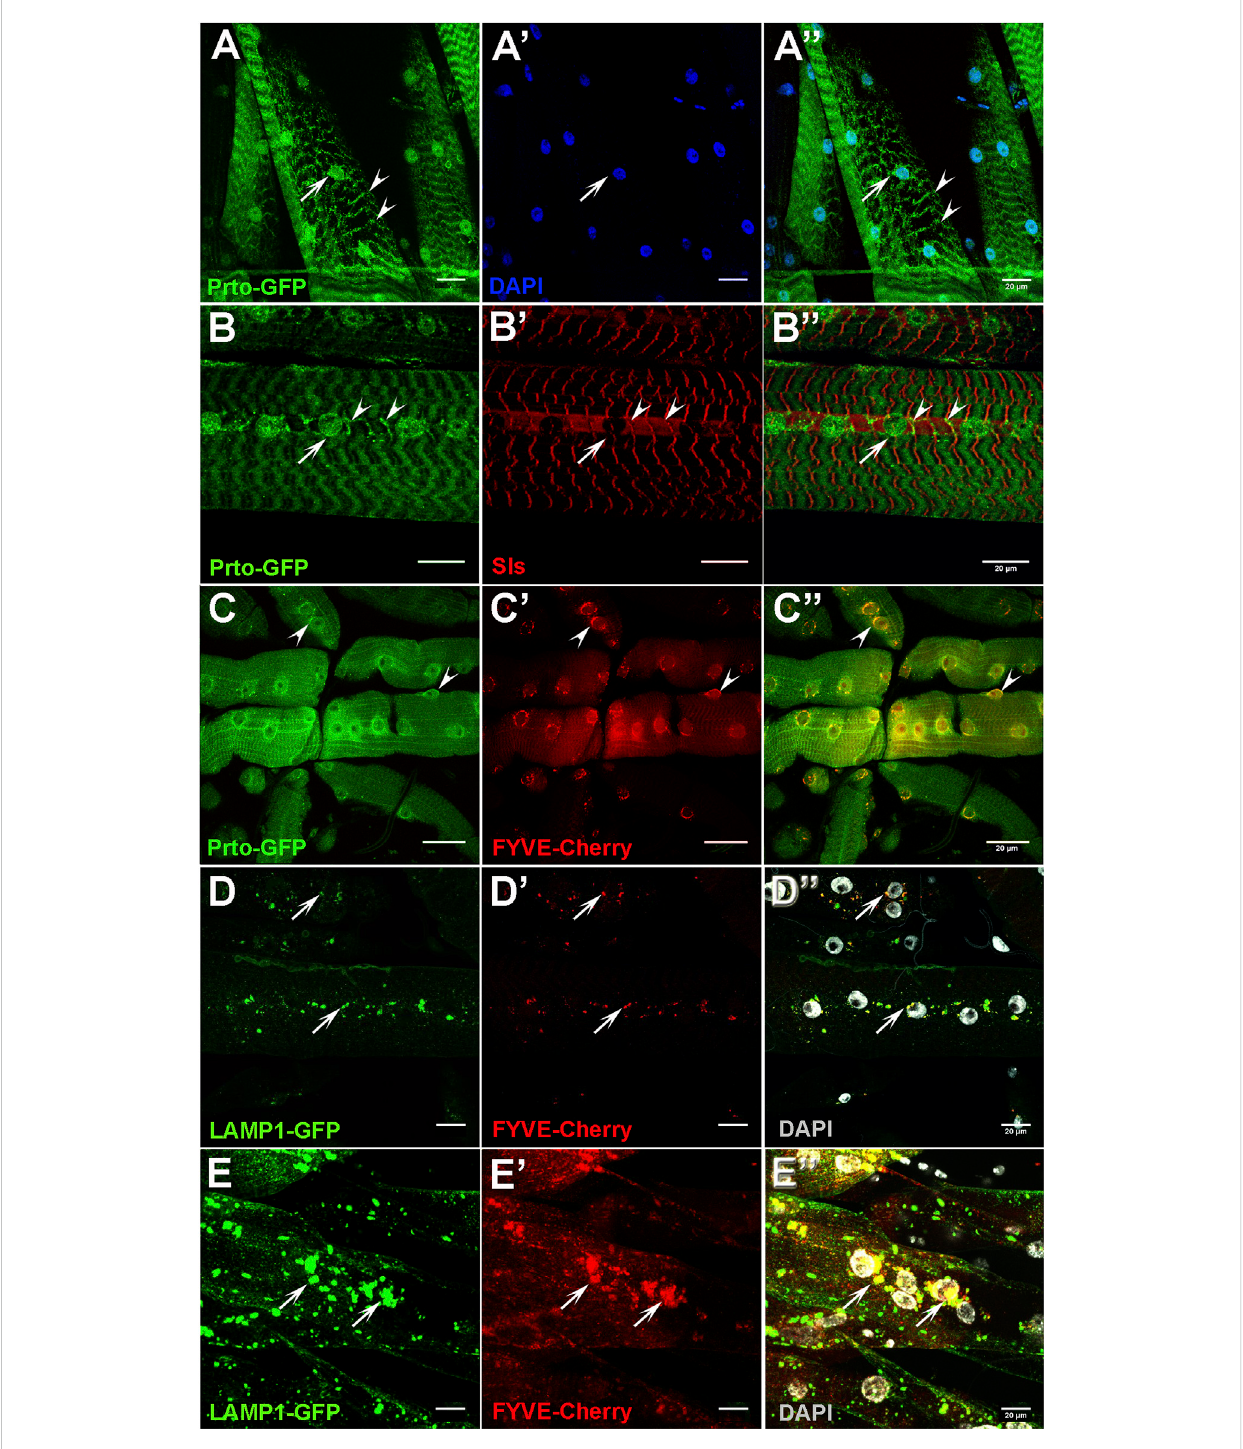
FIGURE 4 Prtolocalisationinendo-lysosomesandZ-diskcompartmentsareimportantformusclefunction. (A – A 9 ) ExpressionofGFP-taggedPrtopeptidesin L3 somatic muscles shows localisation in the perinuclear region (arrow) and in stripes along the sarcolemma (arrowhead) (A) . Nuclei (A 9 ) . Merge image (A 99 ) . (B – B 9 ) Distribution ofPrto-GFP (B) and theSallimus(Sls)protein (B 9 ) inL3muscles.Prto-GFP isdetectedaroundthenuclei (arrow)andinapunctate pattern along the Z-disk (arrowheads) which colocalizes with Sls. Merged image (B 99 ) . (C – C 9 ) Localisation of Prto-GFP (C) and FYVE-Cherry (endosomemarker) (C 9 ) inL3somaticmuscle.Notethatco-localizations(arrowheads)areobservedintheperinuclearregion (C 99 ) . (D – D 99 ) Distributionof the lysosomal (Lamp1-GFP; (D) and the endosomal (FYVE-Cherry; (D 9 ) ) markers in the sarcolemma of control L3 somatic muscles. (D 99 ) Merged image with DAPI labelling nuclei (grey). Arrows denote co-localization near nuclei. (E – E 99 ) Endosome and lysosome distribution in prto KD L3 somatic muscles labelled as in (D – D 99 ) , showing an increase of endo-lysosomal aggregates in sarcolemma (arrows). Scale bars 20